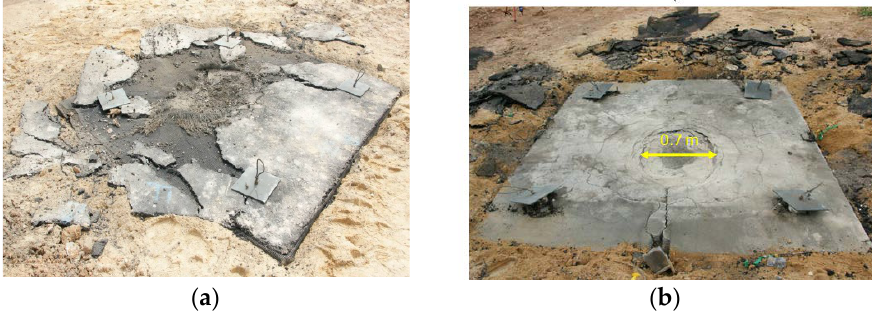
Figure 11. Damage of the multi-layer pavement after blast loading: ( a ) damage pattern of the AC layer in field blast test; ( b ) damage pattern of the HSC layer in field blast test.